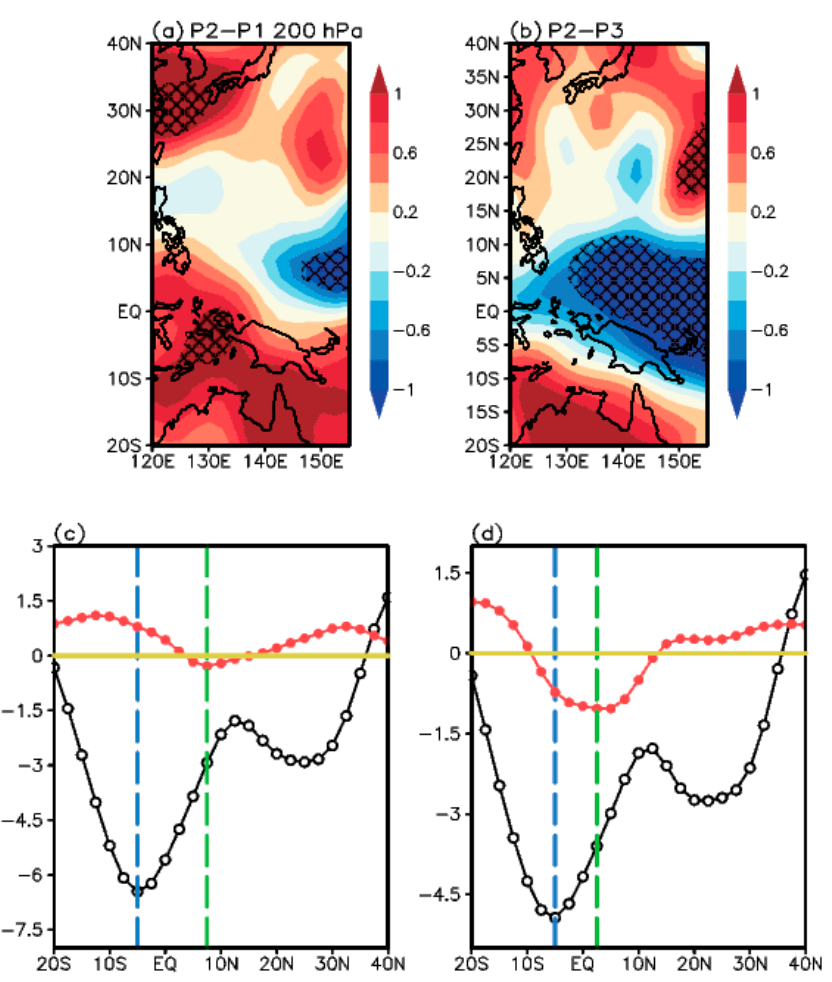
Figure 6. The di ff erences in meridional wind at 200 hPa between ( a ) Period 2 (P2, 1989–2003) and Period 1 (P1, 1979–1988) and between ( b ) P2 (1989–2003) and Period 3 (P3, 2004–2017), where the gridded regions represent the anomalous meridional wind significant at the 95% confidence level (unit m / s); ( c ) The black line denotes the zonally averaged (125 ◦ E–55 ◦ E) meridional wind at 200 hPa during P1 (left ordinate is the magnitude of the wind speed, unit m / s), the red line denotes the di ff erence in the zonally averaged (125 ◦ E–155 ◦ E) meridional wind at 200 hPa between P2 and P1 (P2–P1) (right ordinate is the magnitude of the wind speed, unit m / s); ( d ) The same as ( c ), except, the black line is for P3 (left ordinate is the magnitude of the wind speed, unit m / s), and the red line is for the di ff erence between P2 and P3 (P2–P3) (right ordinate is the magnitude of the wind speed, unit m / s).